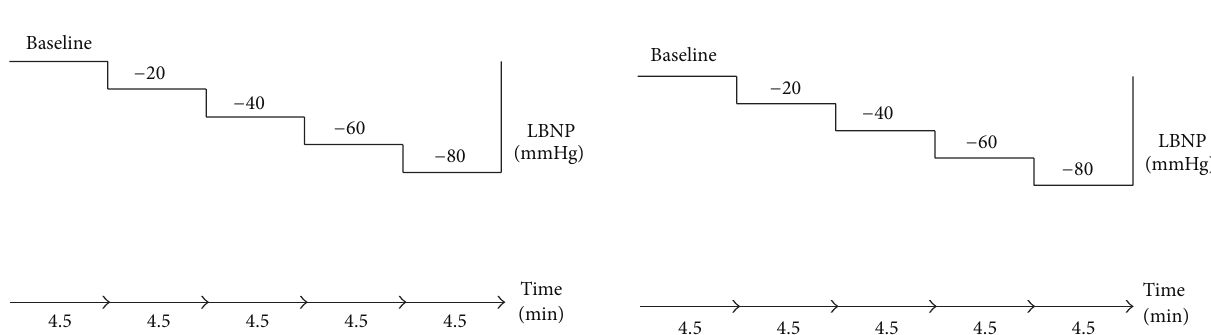
Figure 1: Schematic illustration of the experimental protocol. Each level was kept for 4.5 min. LBNP: lower body negative pressure.